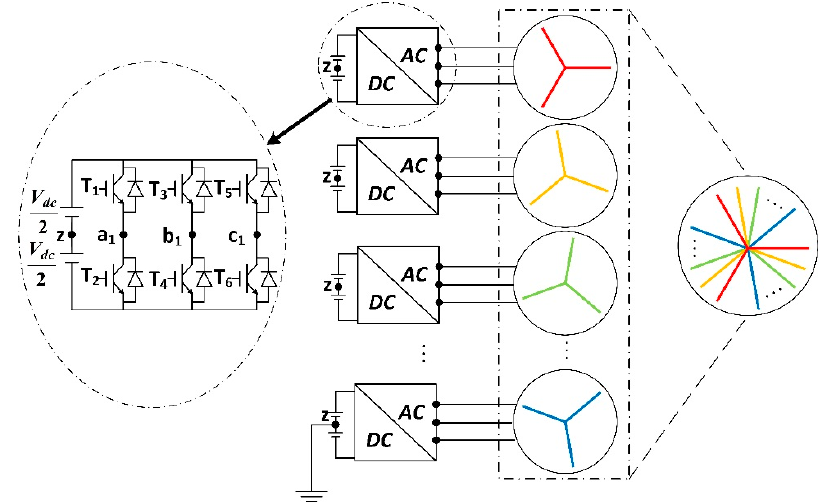
Figure 1. Multi three-phase drives system.